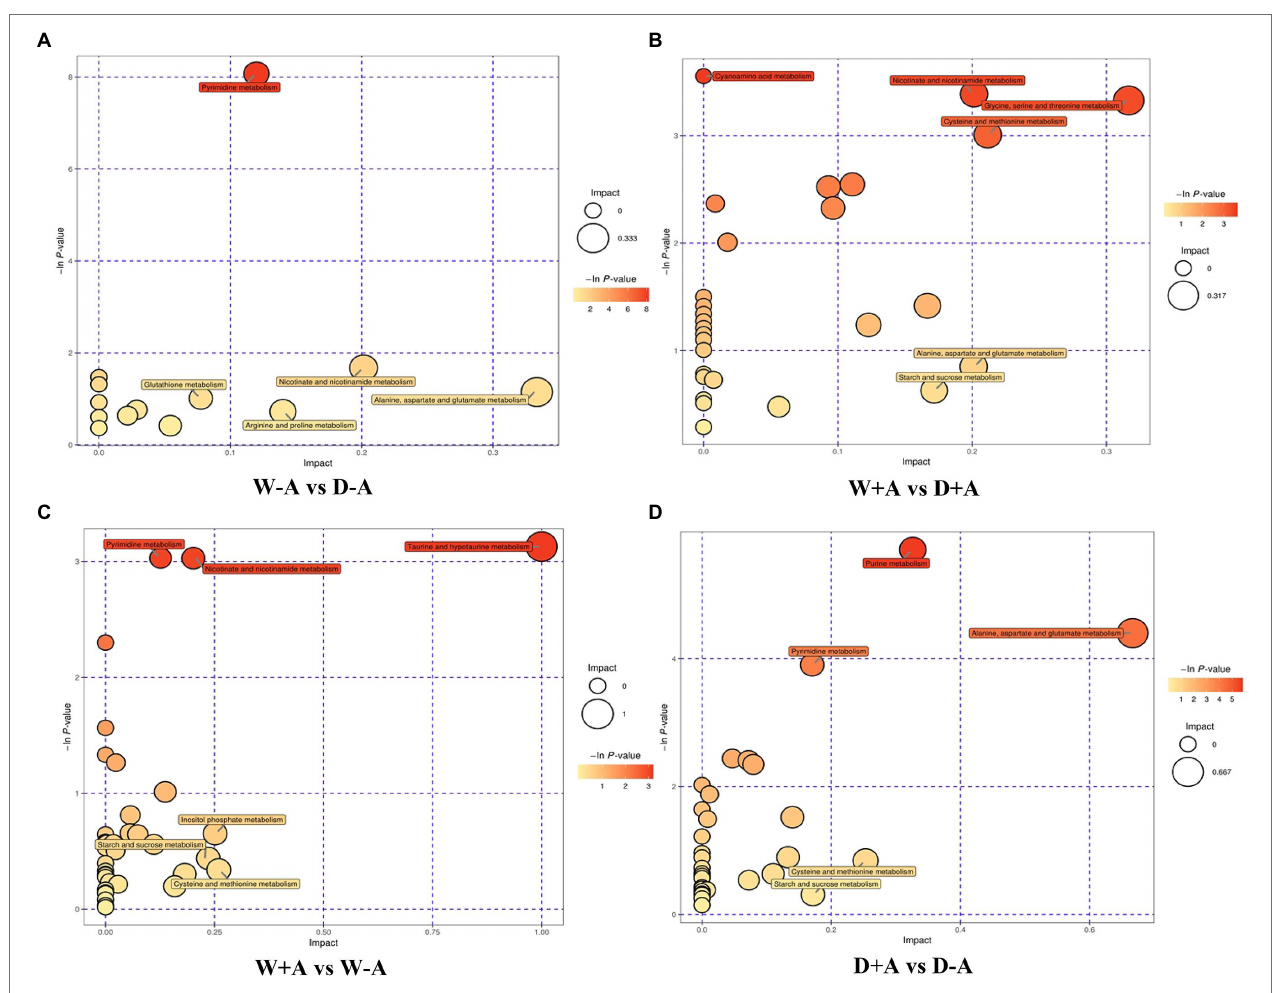
FIGURE 5 | Bubble chart of pathway analysis of different metabolites in different treatment groups of trifoliate orange seedlings under well-watered and drought stress conditions after inoculation with Rhizophagus intraradices . Abbreviation: W + A, inoculation with R . intraradices under well-watered conditions; W-A, inoculation without R . intraradices under well-watered conditions; D + A, inoculation with R . intraradices under drought stress conditions; D-A, inoculation without R . intraradices under drought stress conditions; mix, quality control